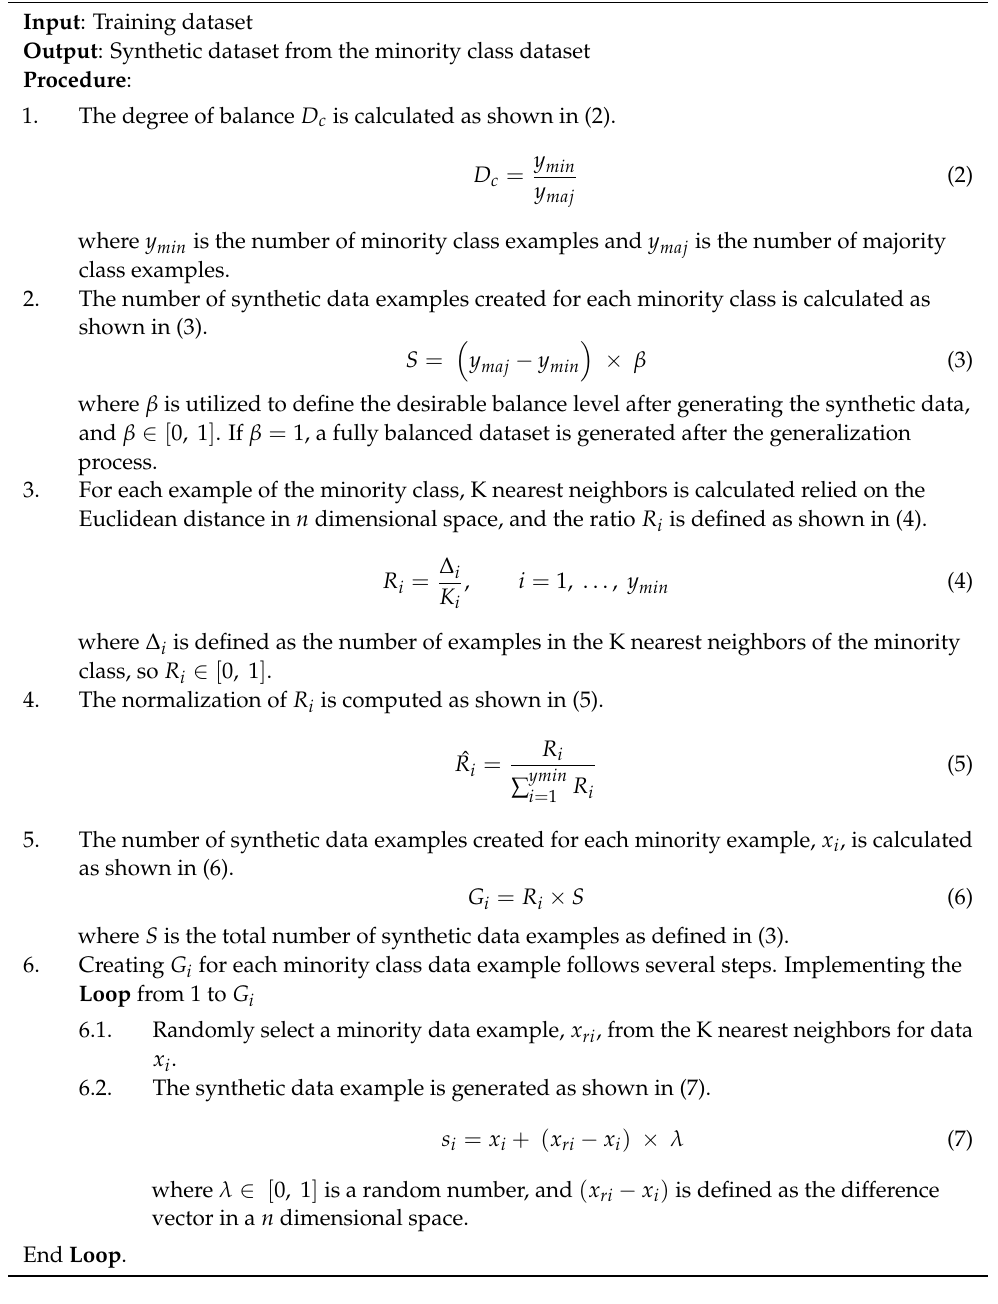
Algorithm 1. ADSYN